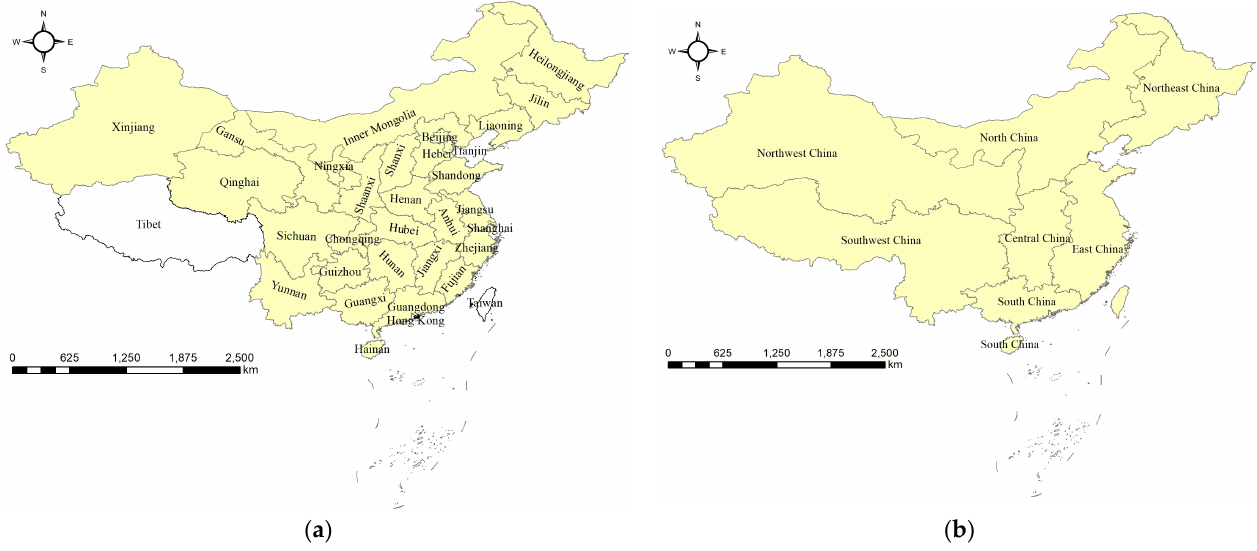
Figure 4. The visualization of the study area: ( a ) the 30 provinces, and ( b ) the seven geographical